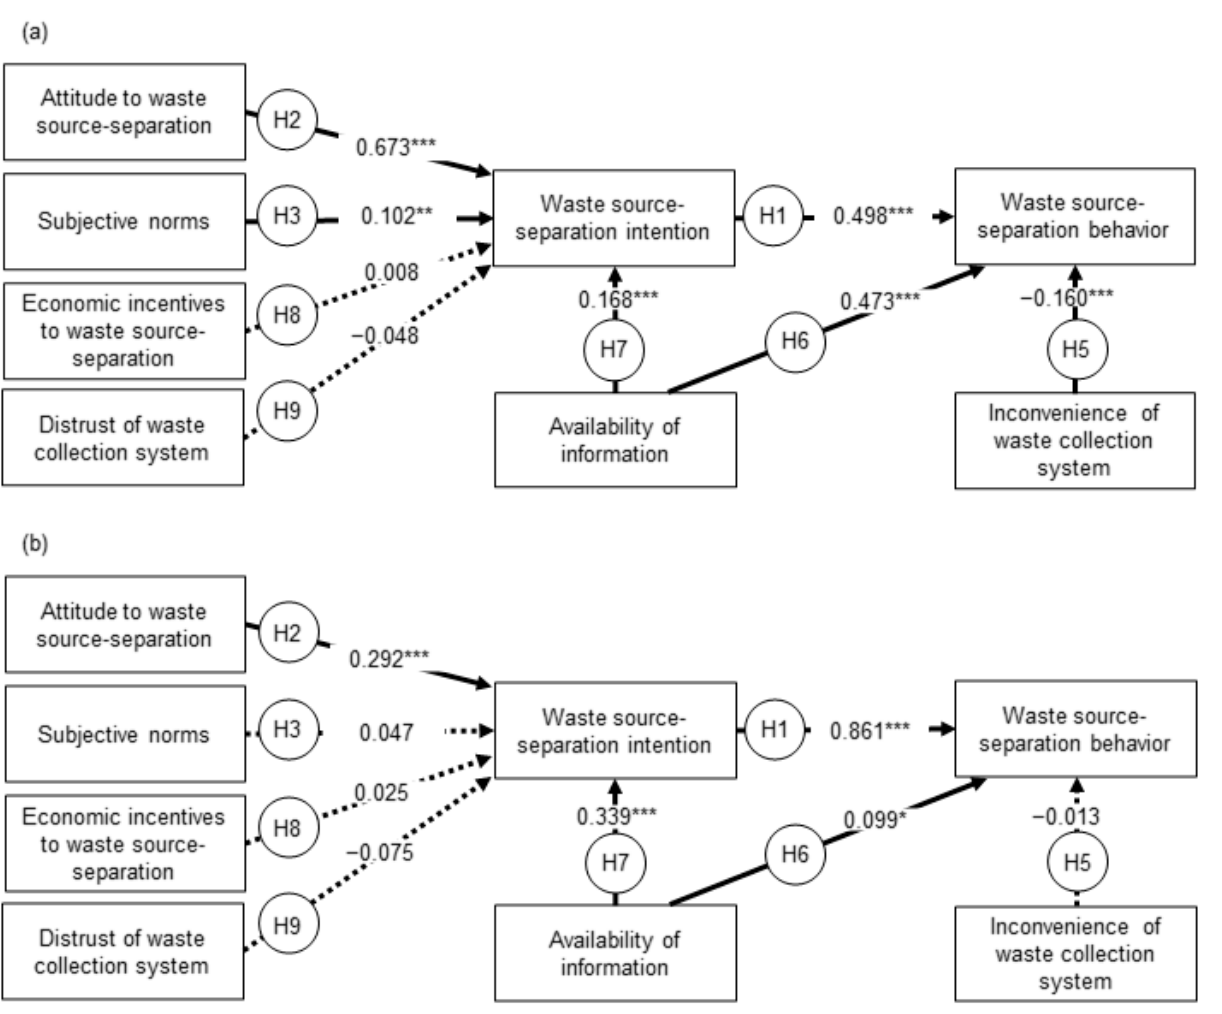
Figure 2. The estimated structural equation model: ( a ) Russian case, ( b ) Finnish case. Coefficients are standardized regression weights (path coefficients). * Significant at p < 0.1; ** Significant at p < 0.01; *** Significant at p < 0.001. Solid arrows represent supported hypotheses; dotted arrows represent unsupported hypotheses.